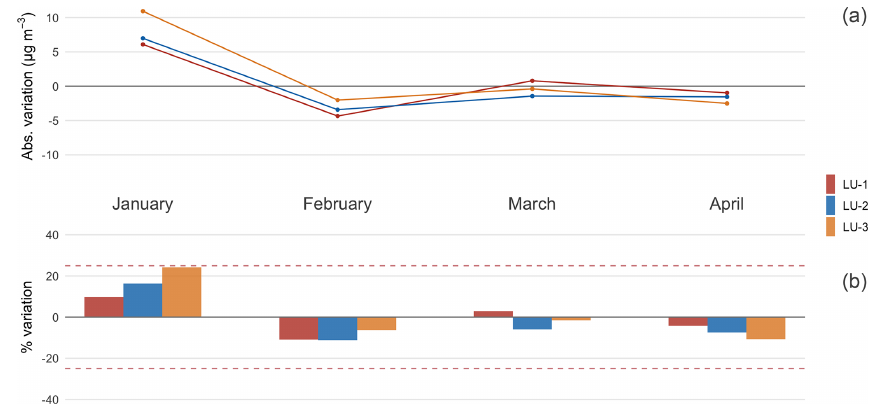
Figure 2. Plain of Lucca area: PM 10 (a) absolute variation and (b) percentage variation between monthly means of 2020 and 2017–2019.